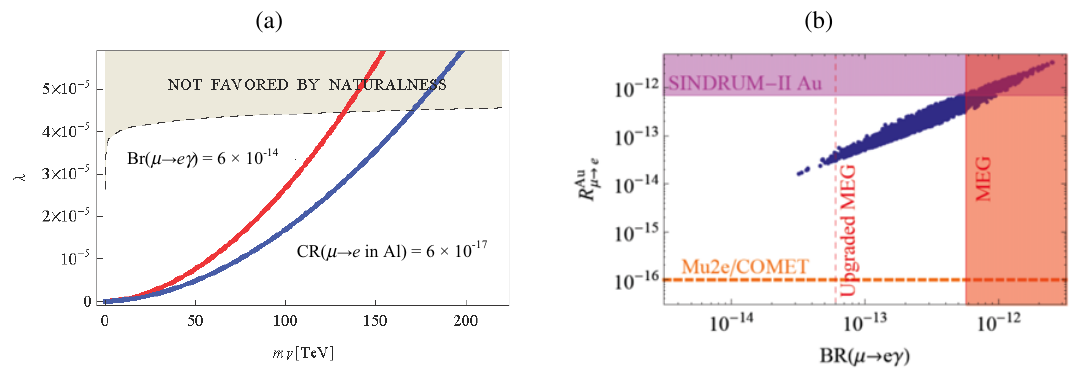
Figure 2. ( a ) Reach acheavable in scalar leptoquark search for Upgraded MEG and Mu2e as a function of the coupling λ and the scalar leptoquark mass. ( b ) Expected BR and R μ e for Left-Right symmetric models for Upgraded MEG and muon conversion